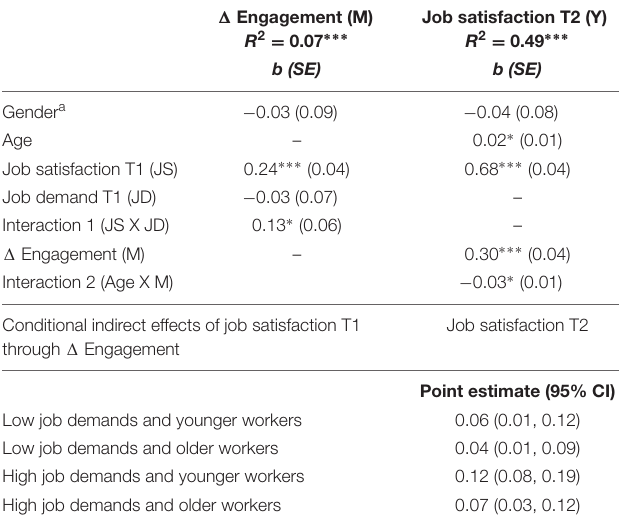
TABLE 2 | Direct and indirect effects of hypothesized model.